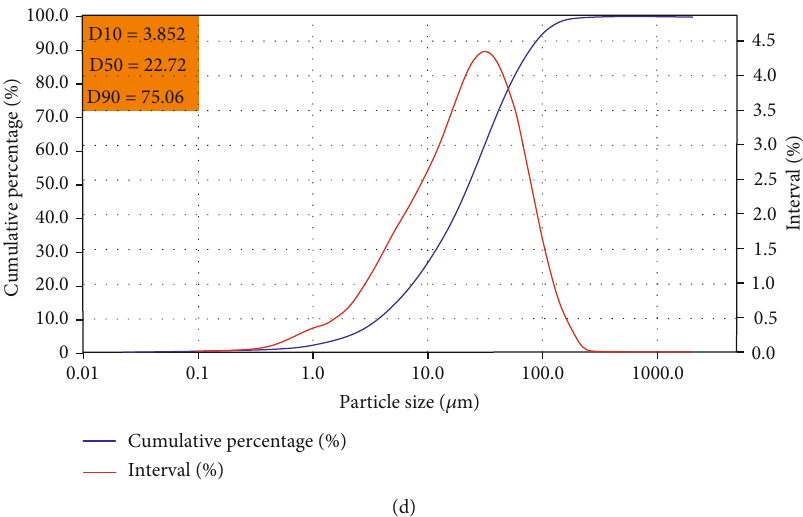
Figure 5: Particle size distribution curves of di ff erent coal fi ne types ((a) ZX, (b) FP, (c) LS, and (d)